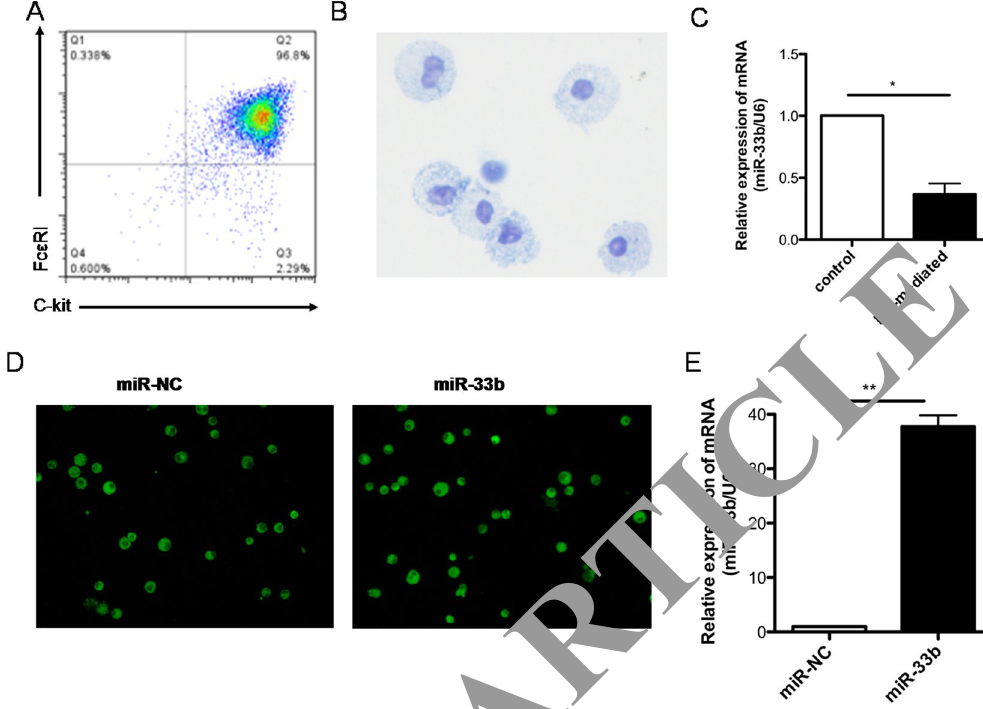
Figure 4. MiR-33b was down-regulated in IgE-mediated activation of bone marrow mast cells (BMMCs) and was overexpressed in transfected BMMCs. ( A ) Representative FACS for c-Kit and Fc ε RI expression in BMMCs. ( B ) Toluidine blue was used to identify the mast cells. ( C ) The expression of miR-33b was analyzed using qRT-PCR in BMMCs that were activated through IgE. ( D , E ) Immunofluorescence and qRT-PCR were used to evaluate the miR-33b transfection